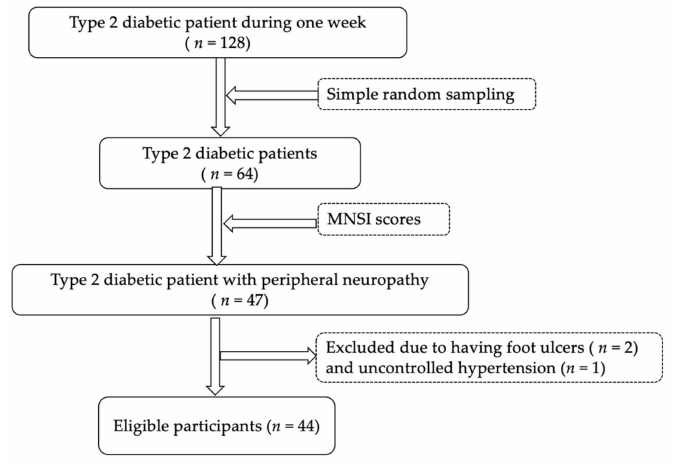
Figure 1. The flow diagram of the participant recruitment